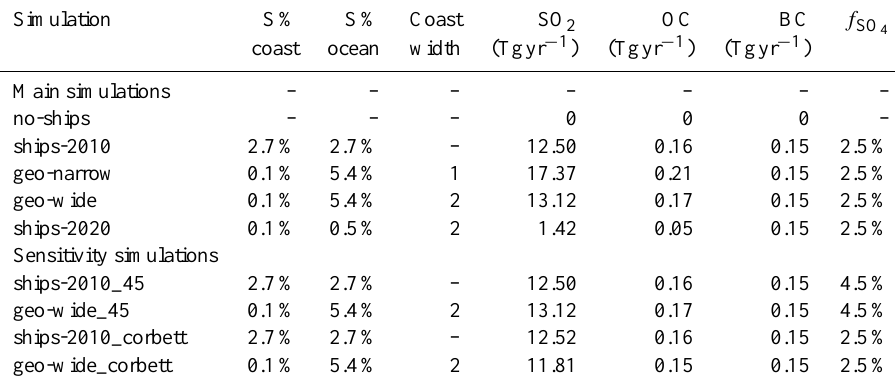
Table 1. List of simulations ∗ .